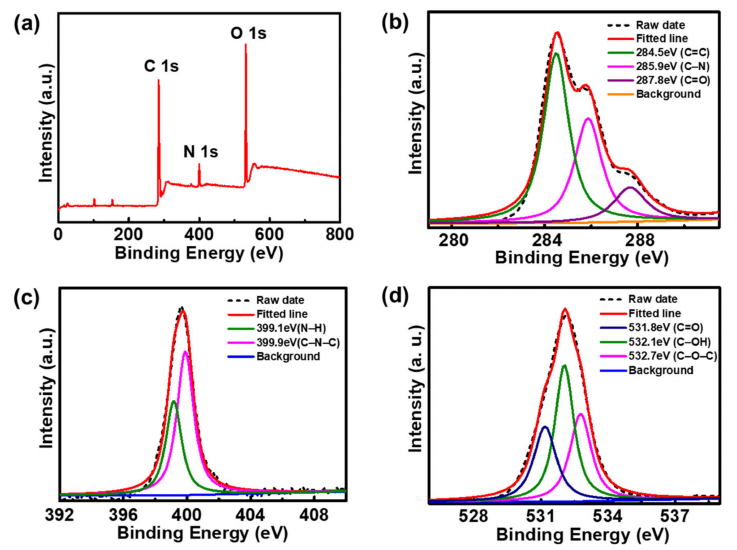
Figure 3. ( a ) XPS full survey spectra of F-CDs, and the corresponding ( b ) C 1s, ( c ) N 1s, and ( d ) O 1s high-resolution XPS spectra of